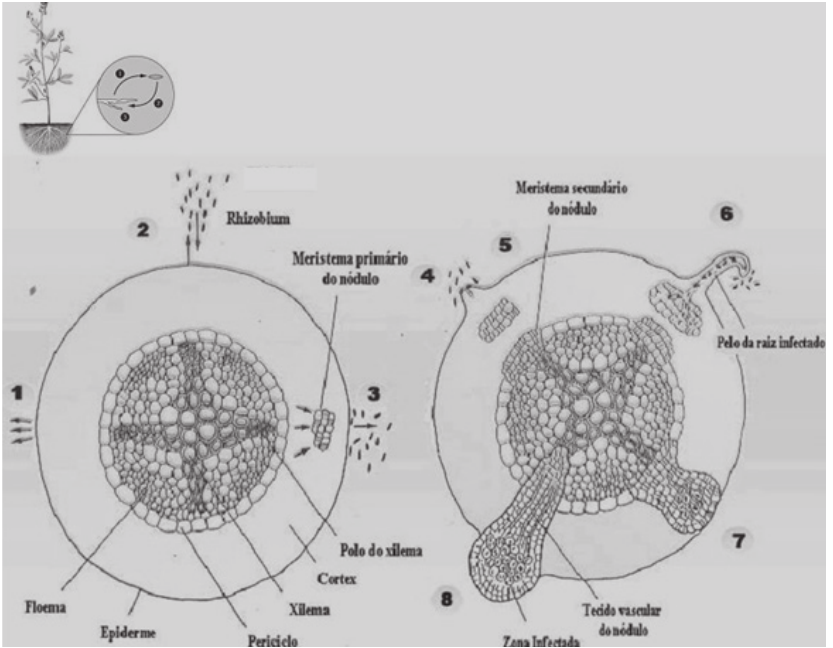
Figura 2. Forma correta, mostrando a infecção da raiz de leguminosa por bactérias do gênero Rhizobium com formação do nódulo (Madigan et